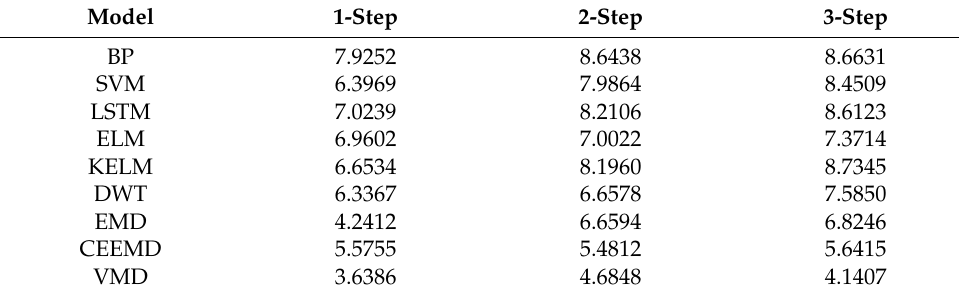
Table 7. Diebold–Mariano (DM) test of different